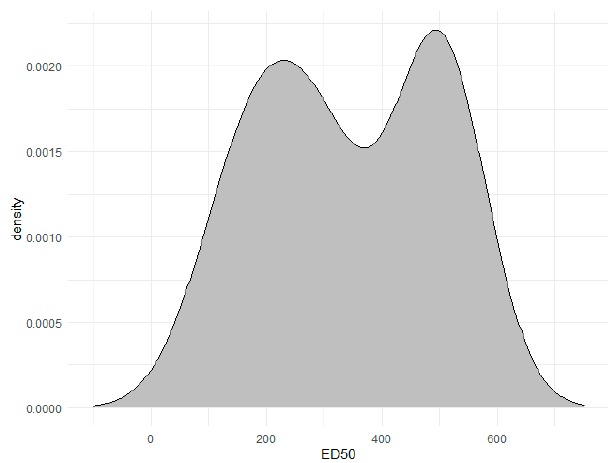
Figure 10. The distribution of activity parameter.